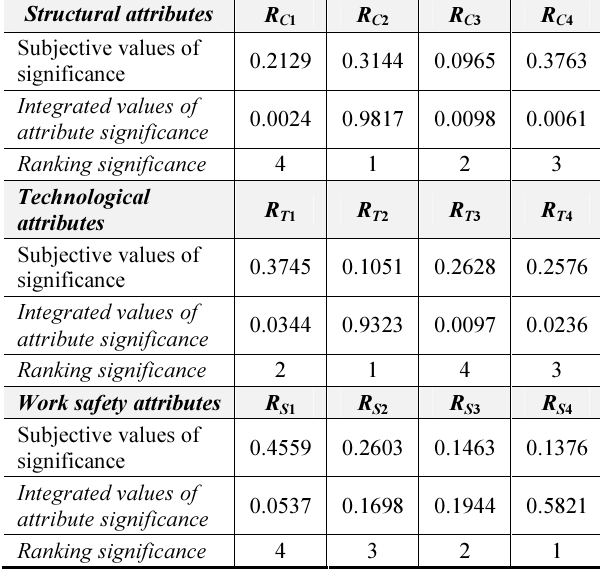
Table 4. The values of attribute significance